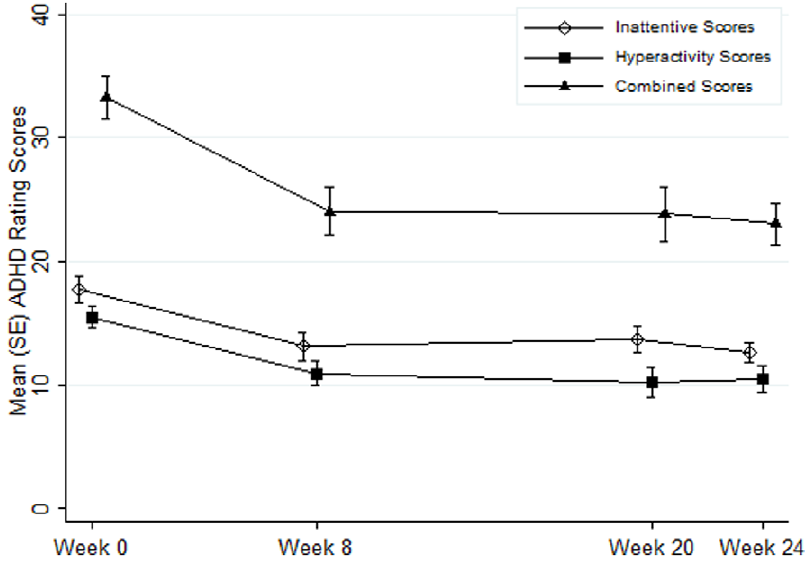
Figure 3. Mean ADHD Rating Scale IV (ARS-IV) Scores as rated by parents.